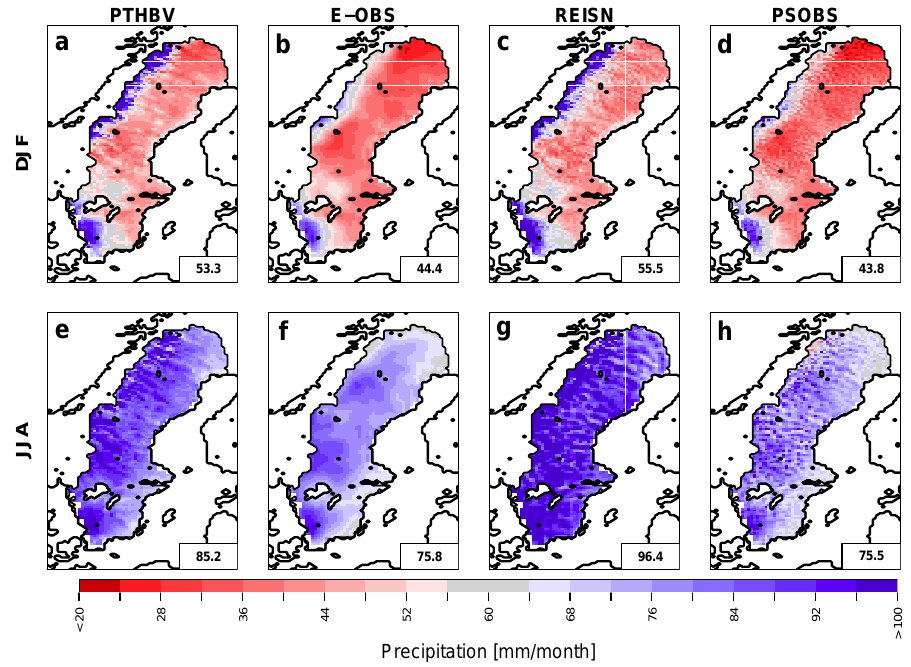
Figure 2. ( a–d ) Winter and ( e–h ) Summer Seasonal mean precipitation for (a,e) PTHBV, (b,f) E-OBS, (c,g) REISN and (d,h) PSOBS. The domain average value is given in the lower right box in each